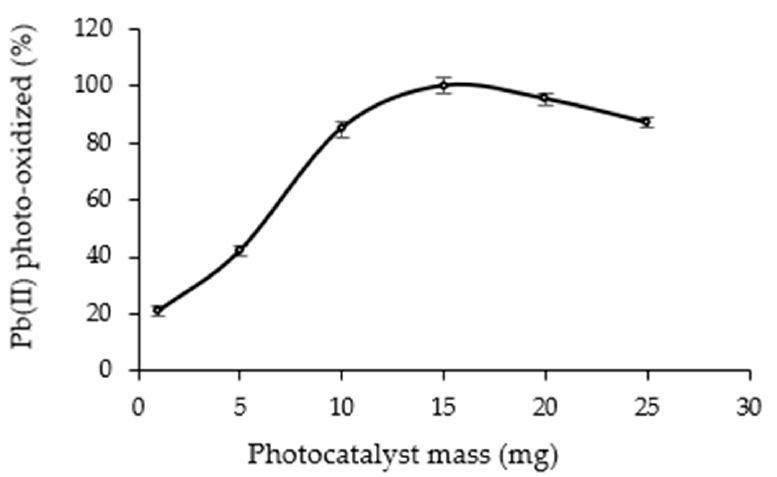
Figure 7. The influence of the photocatalyst mass on the Pb(II) photo-oxidation (volume of Pb(II) solution = 25 mL, Pb(II) concentration = 15 mg/L, reaction time = 30 min and solution pH = 7).